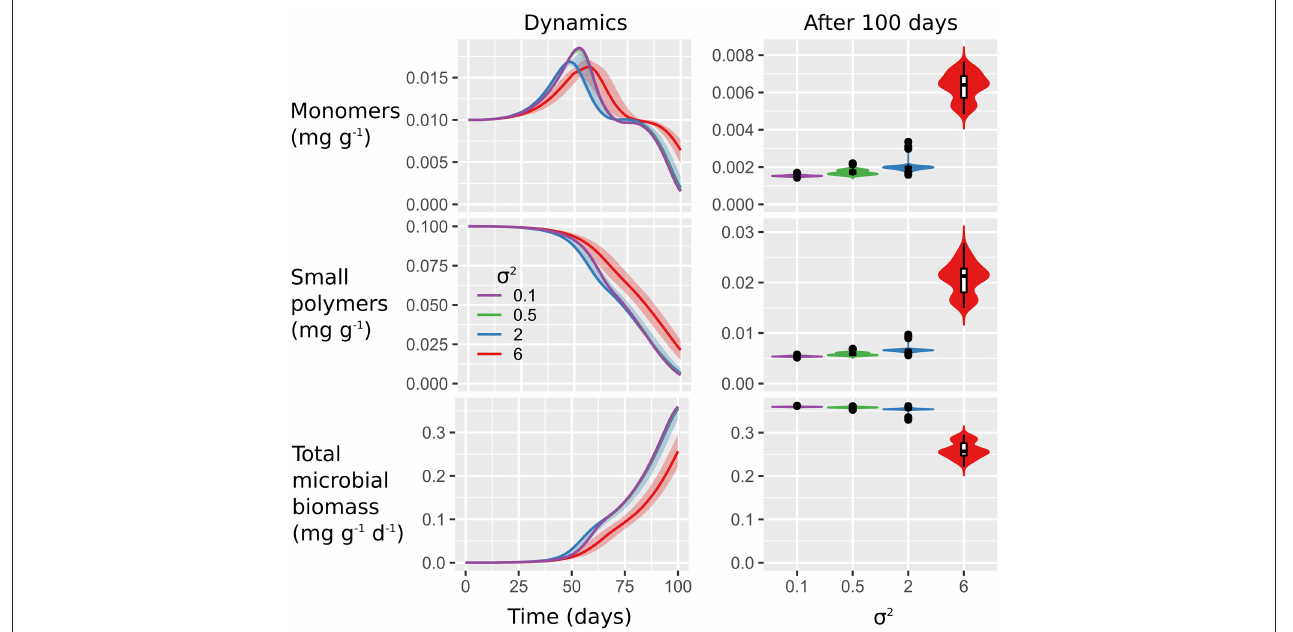
FIGURE 4 | Microbial biogeography triggers only small changes in carbon utilization. Plots show C turnover dynamics (left) and final values (right) of dissolved monomers and small polymers as well as total microbial biomass C in response to spatial heterogeneity of the initial distribution of microorganisms ( σ 2 = 0.1, 0.5, 2, 6). Values are aggregated over the 100 × 100 mm 2 soil domain. Lines indicate the medians of 100 realizations and shaded areas show minimum and maximum values (left). Violin plots (right) are scaled to the same width and show the relative distribution of final values. In the inserted box plots, horizontal lines indicate median values, boxes show interquartile ranges (IQR) and whiskers reflect values within maximum 1.5 × IQR.